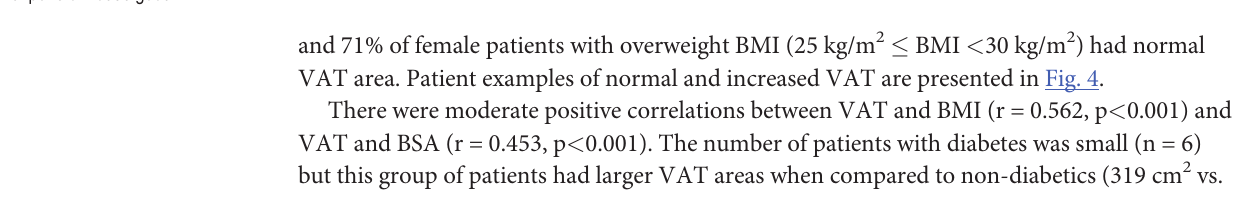
Fig 3. Age adjusted mean values and their 95% confidence intervals of visceral adipose tissue (VAT) and the conventional risk factors in patients with ESUS compared to the three control populations. Statistically significant differences between patients with ESUS and reference populations are marked by * (p < 0.05) and ** (p <